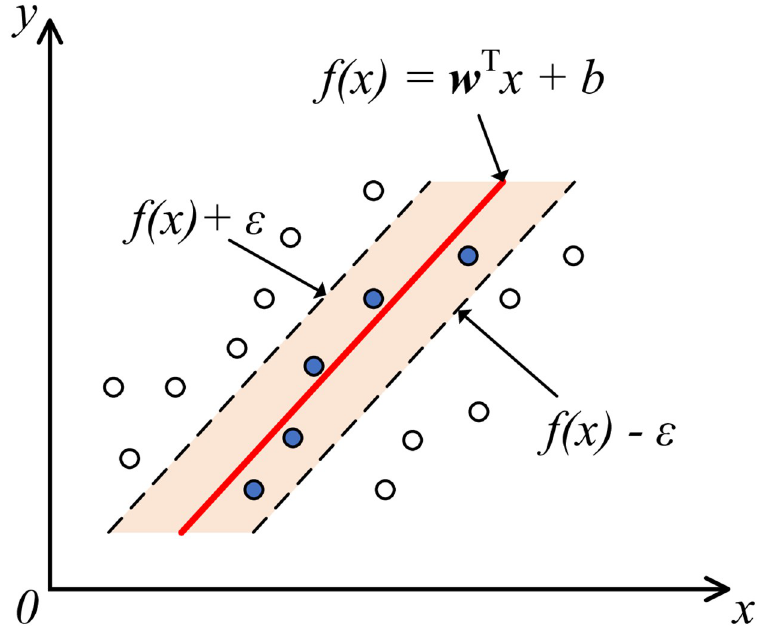
Fig 6. Support vector regression